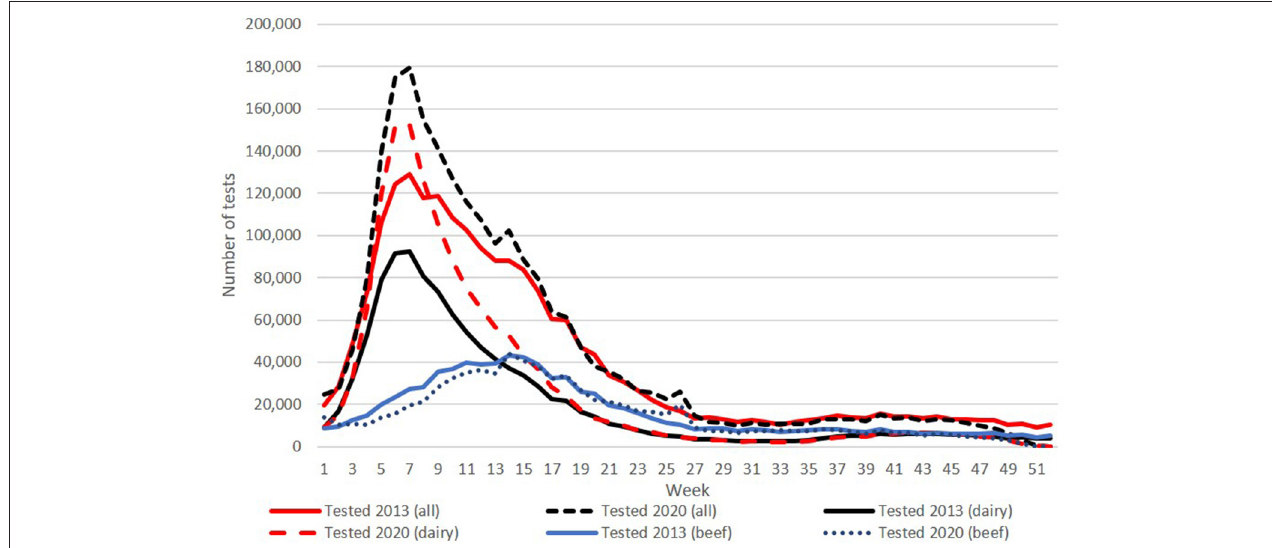
FIGURE 1 | Number of tests conducted per week in 2013 (solid lines) and 2020 (broken lines) for all calves and, separately, for calves born in either dairy herds or beef herds.